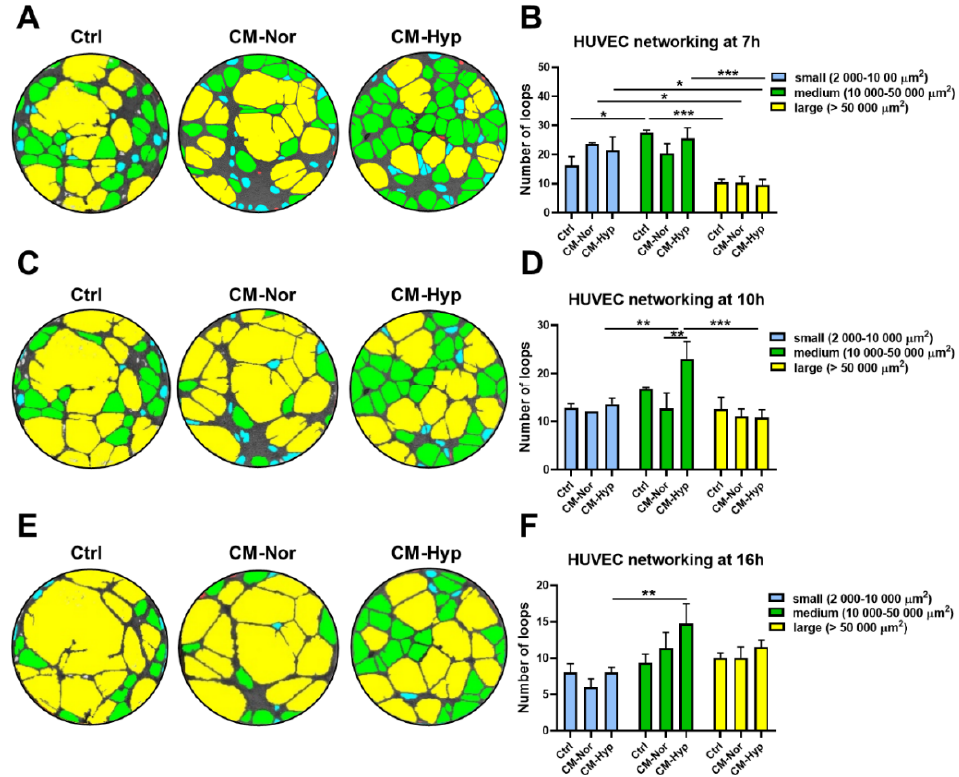
Figure 7. CM-Hyp increases formation and survival of HUVEC networking. Representative pictures of endothelial cells tube formation in CM-Nor, CM-Hyp, or control medium and their analysis at ( A , B ) 7 h, ( C , D ) 10 h, and ( E , F ) 16 h of culture demonstrated small-(blue), medium-(green), and large- (yellow) sized loops. The results are shown as the mean ± SD. The asterisks indicate significant differences in loops number between specific media (* p < 0.05, ** p < 0.01, *** p < 0.001). Abbreviations: HUVEC, human umbilical vein endothelial cells; CM-Nor, conditioned medium collected from pASCs exposed to normoxia; CM-Hyp, conditioned medium collected from pASCs cultured under